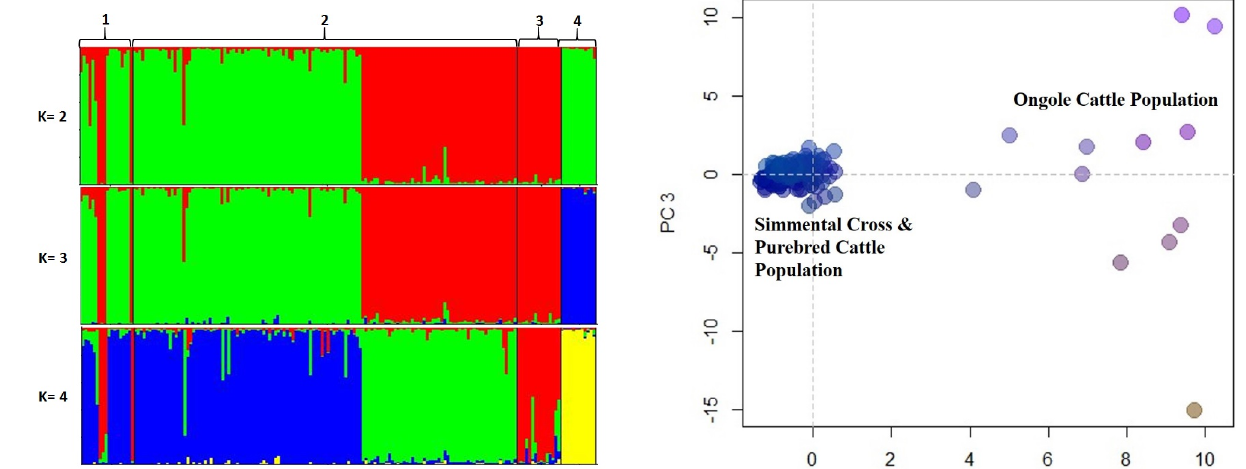
Figure 3. Genetic structures of the Simmental Purebred cattle population (1), the Simmental Cross-West Sumatra (2), the Simmental Cross-West Java (3), and the Ongole Grade (PO) breed (4). Black lines separate individual populations whose names are indicate.